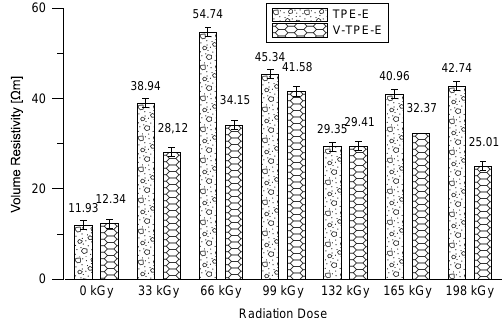
Figure 3. Volume resistivity at voltage of 500 V after 60